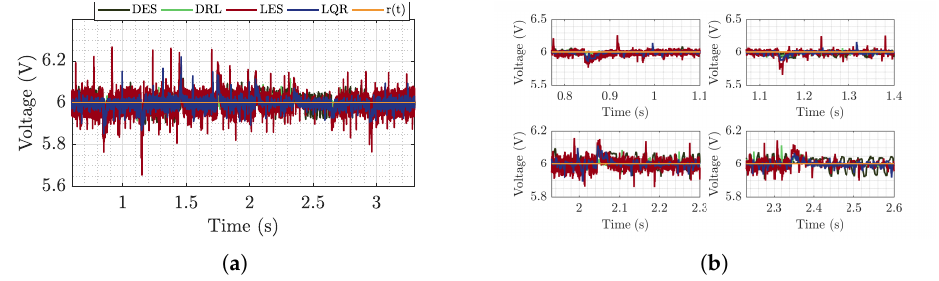
Figure 19. ( a ) Regulated voltage delivered to the DC bus during the test. ( b ) Zoom to the oscillations caused by the power variation of the CPL buck.